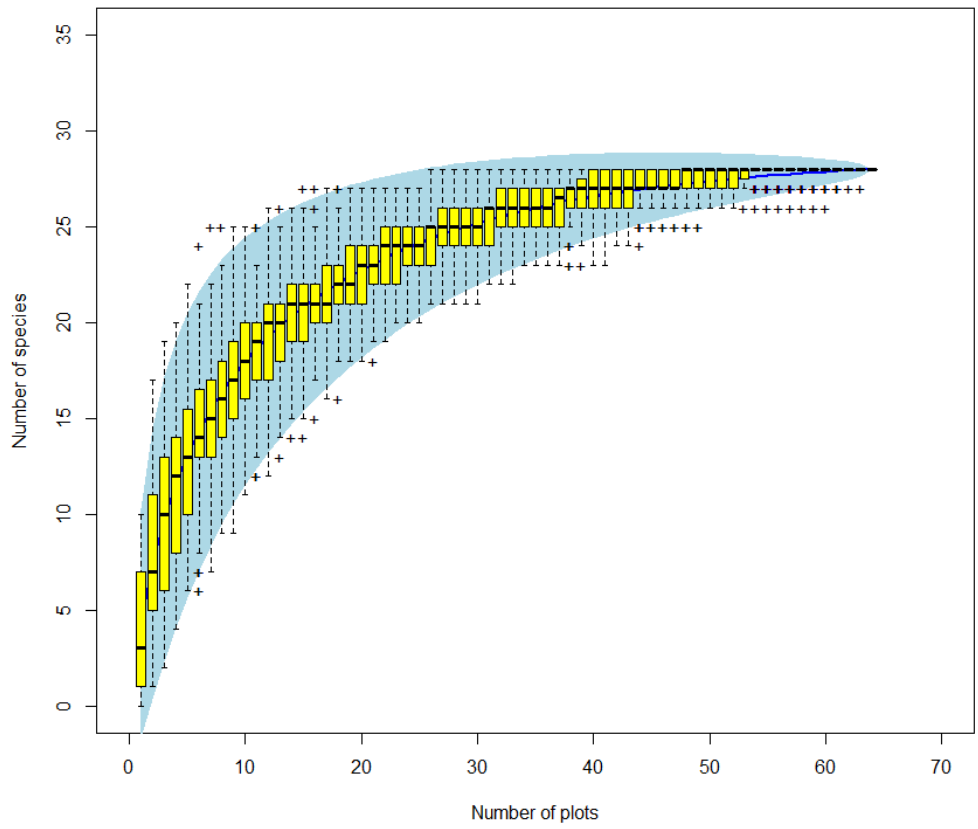
Figure A2. Species accumulation curves in reclamation well sites showing number of species (mean ± SD) versus number of plots.